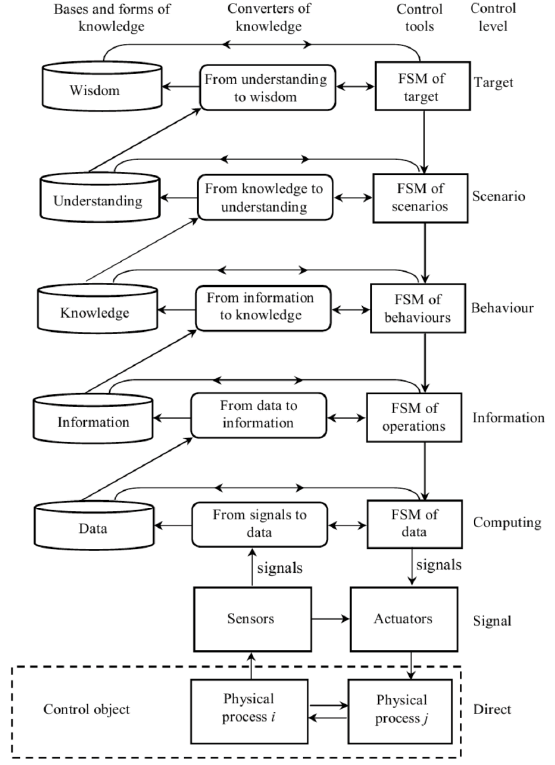
Fig. 1. Model of a cognitive control system